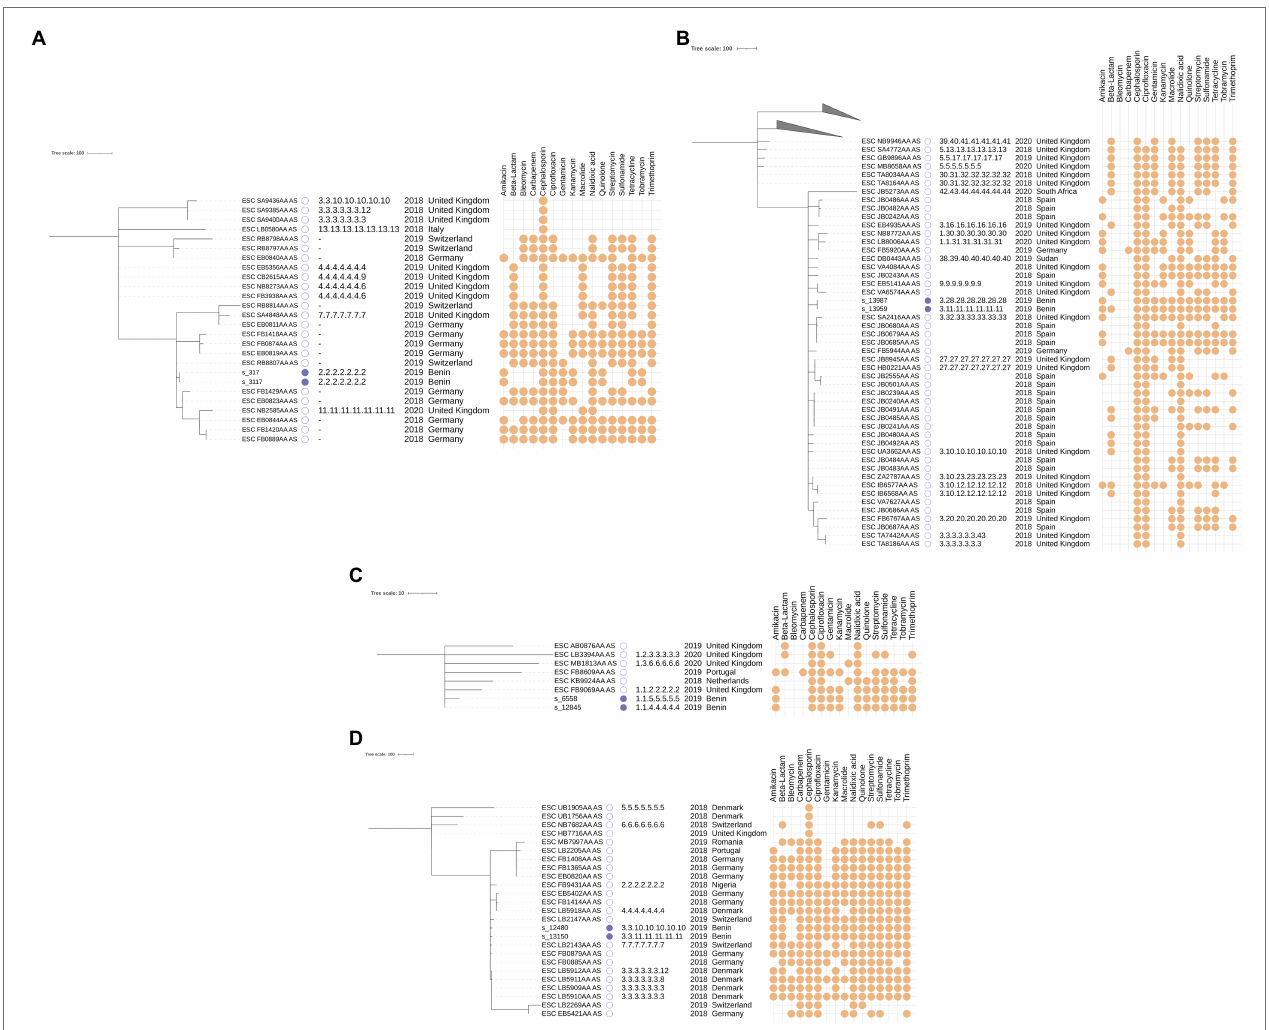
FIGURE 3 | cgMLST-based minimum spanning trees annotated with SNP typing results for samples classified as ST405 (A) , ST131 (B) , ST1193 (C) , and ST410 (D) . The scale bar and branch lengths are expressed as the number of allele differences. Annotations are (from left to right) as: sample name, sample origin (this study with a filled blue box or EnteroBase with an empty box), SNP address, isolation year, isolation country, and predicted AMR susceptibility based on genotypic AMR prediction. Samples with missing SNP addresses did not have publicly available Illumina paired-end data or were filtered out because their coverage was too low. Predicted AMR susceptibility is shown for the 16 antibiotics that were most often predicted (full results are provided in Supplementary Table S5 ). The top two clades in subfigure B were collapsed for visual clarity and contain 18 and 9 isolates,